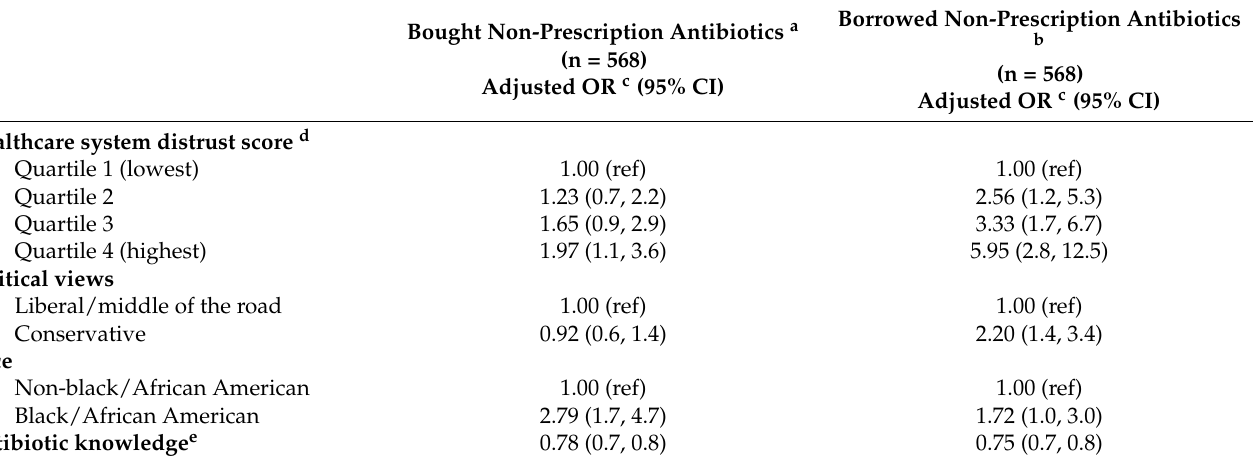
Table 4. Results of sensitivity analyses: relationship between healthcare system distrust and non- prescription antibiotic use, non-prescription antibiotic use redefined (n =